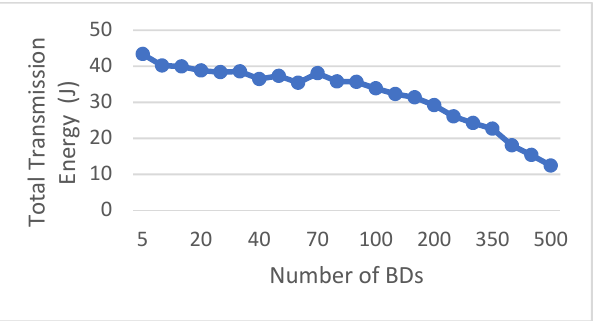
Figure 15. The total transmission energy vs. the number of BDs in the LMF model.